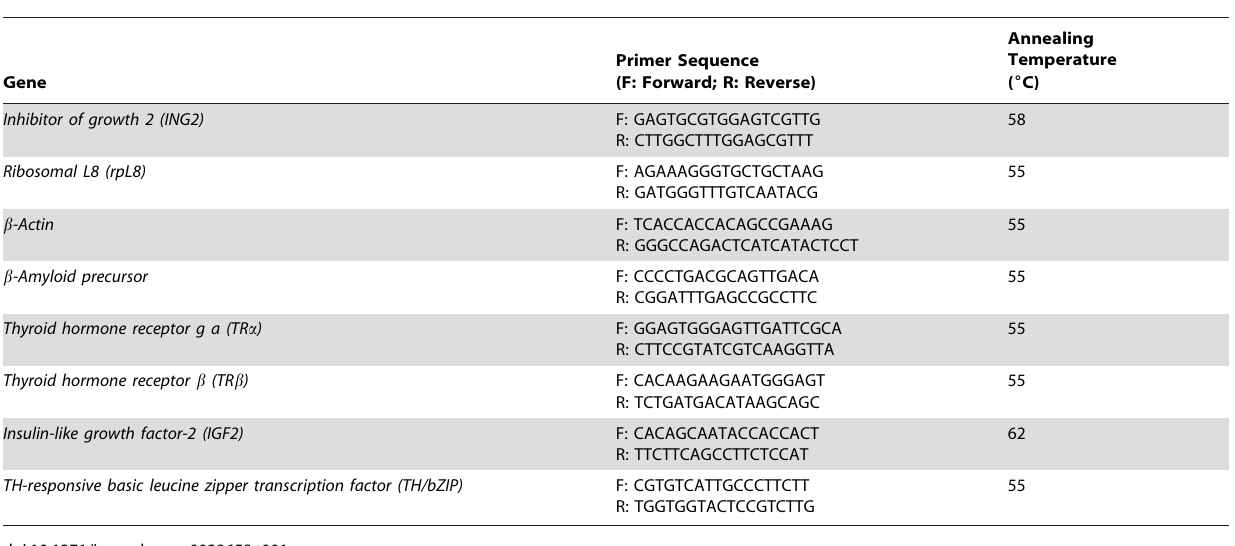
Table 1. QPCR primer sequences and annealing temperatures.